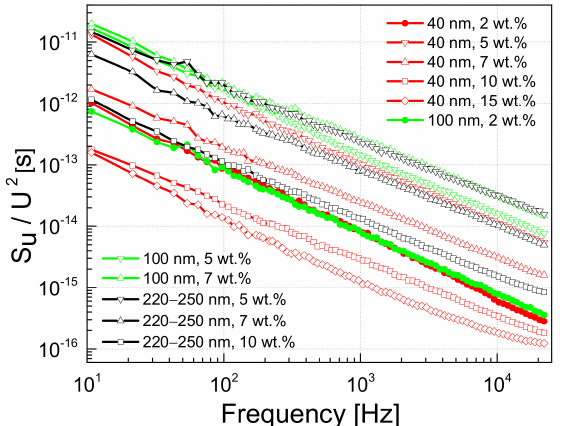
Figure 8. Spectra of the voltage noise for composites with different filler concentrations and different OLC particle sizes at 290